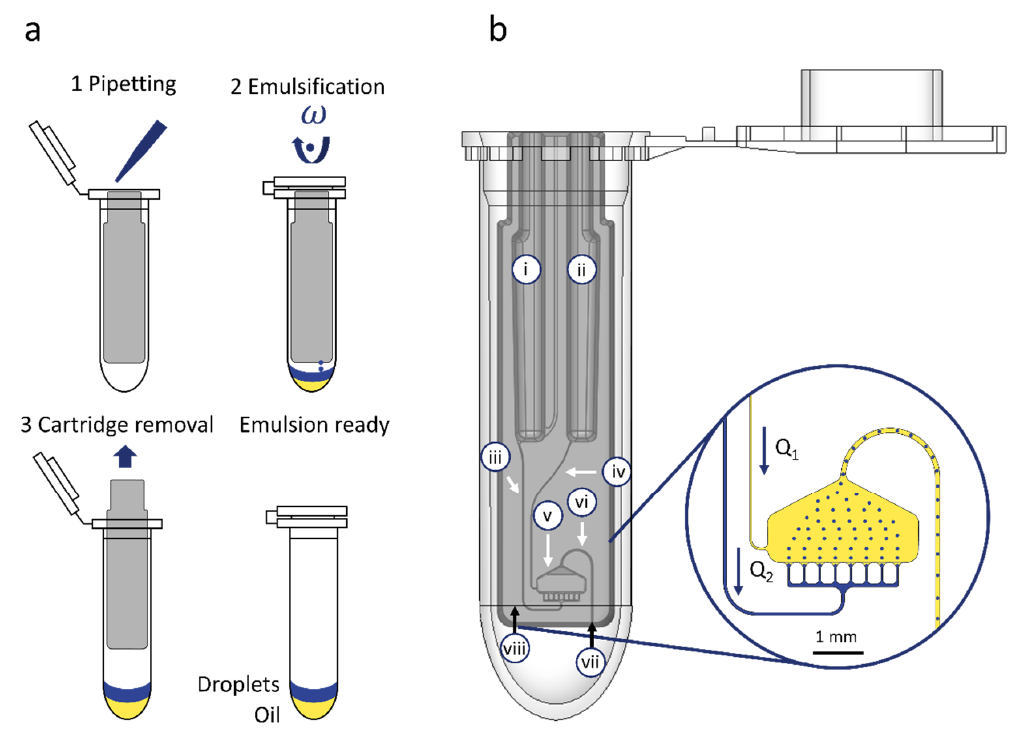
Figure 1. Overview of workflow and microfluidic cartridge design. ( a ) Schematic depiction of the workflow for cartridge loading by pipetting oil and water-based sample, emulsification and cartridge removal. ( b ) 3D-CAD view of the cartridge in a standard 2 mL tube with an insert depicting the droplet generation and transfer into the tube: (i) Sample inlet; (ii) oil inlet; (iii) sample supply channel; (iv) oil supply channel; (v) droplet generation unit; (vi) outlet channel; and (vii) outlet nozzle where the droplets exit the cartridge. (viii) rcf reference point. In both cases, the blue color represents the droplets and yellow color the fluorinated oil.